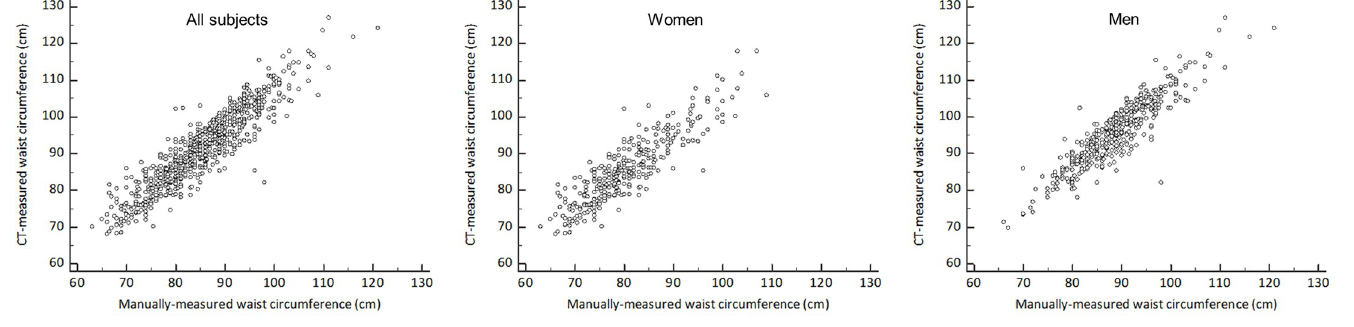
PLOS ONE | https://doi.org/10.1371/journal.pone.0254704 July 19,